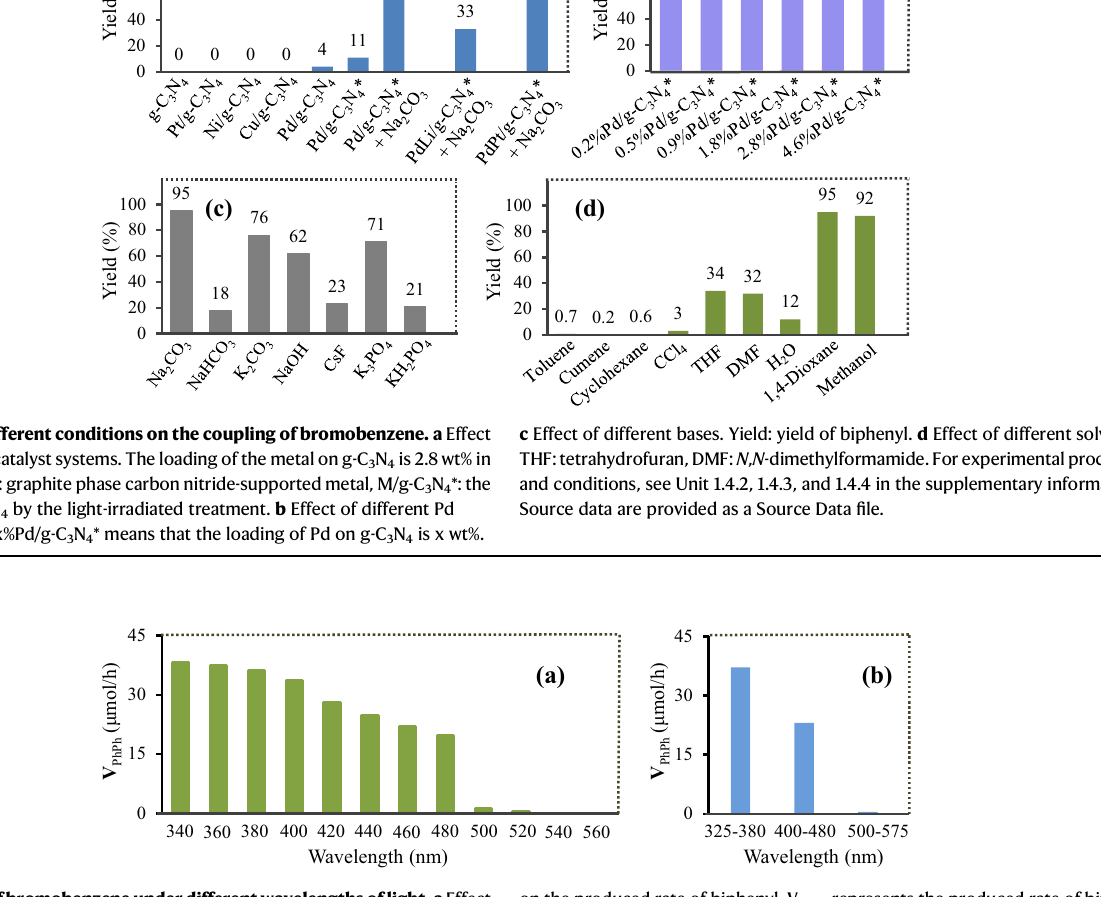
on the produced rate of biphenyl. V PhPh represents the produced rate of biphenyl. For experimental procedures and conditions, see Unit 1.4.5 in the supplementary information. Source data are provided as a Source Data fi